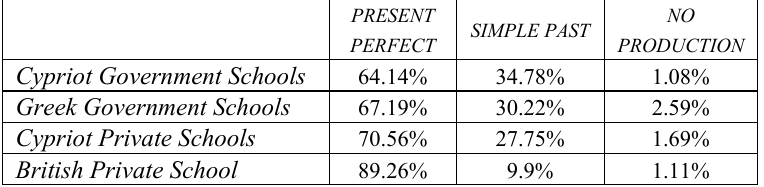
Table 2: Performance of all the pupils in all the tests